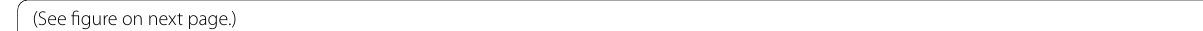
figure on next Fig. 1 a Bathymetric map showing the location of Core KY07-04 PC01, MD98-2195 (yellow star), A7, and DGKS9604 (yellow circle) in the East China Sea. Dotted lines indicate 100 m water depth. Surface water masses (Kuroshio, Chinese coastal water, Changjiang River Diluted Water (CRDW), and Tsushima Warm Current (TSWC)) are shown. b Lower panels show the annual mean of sea-surface temperature (SST) and c sea-surface salinity (SSS) based on the World Ocean Atlas 2018 (Locarnini et al. 2018; Zweng et al.